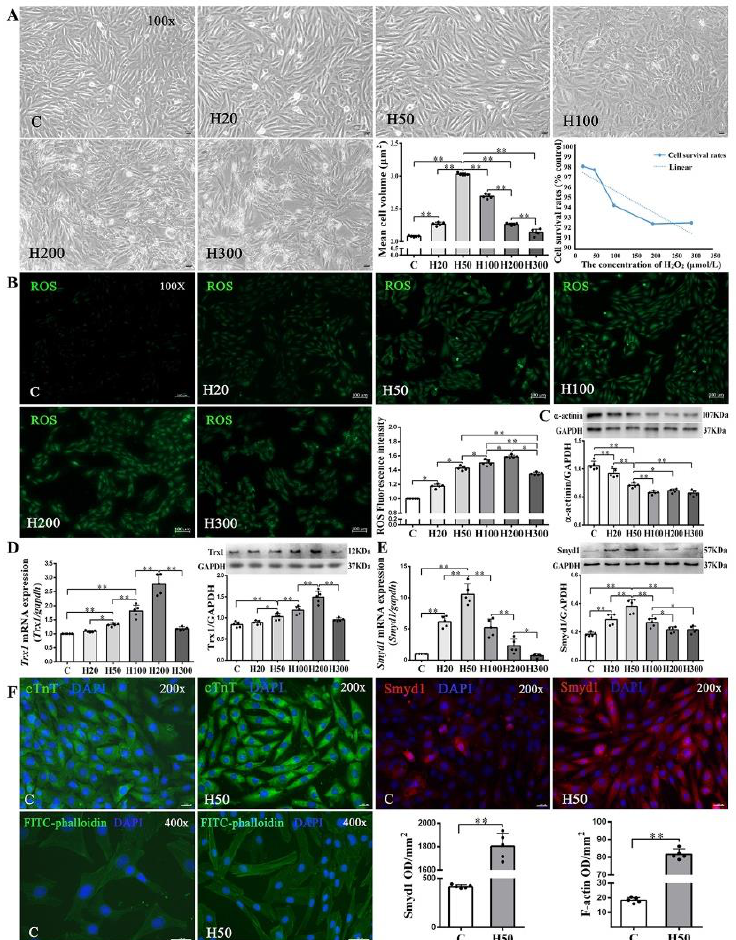
Figure 5. Effects of H 2 O 2 on H9C2 cell size and Smyd1, Trx1, and F-actin expression: ( A )